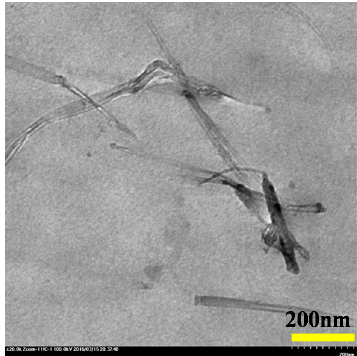
Figure 2. TEM image of as-irradiated poly(vinylidene fluoride) (PVDF)/IL-CNTs (100/10-1).